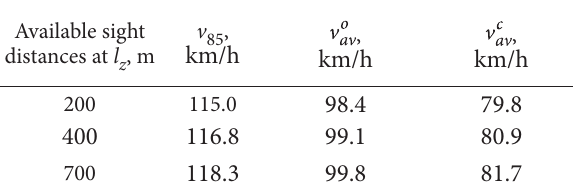
Table 2. Road features benchmark values summary (Sołowczuk 2005) Available sight distances at l z ,